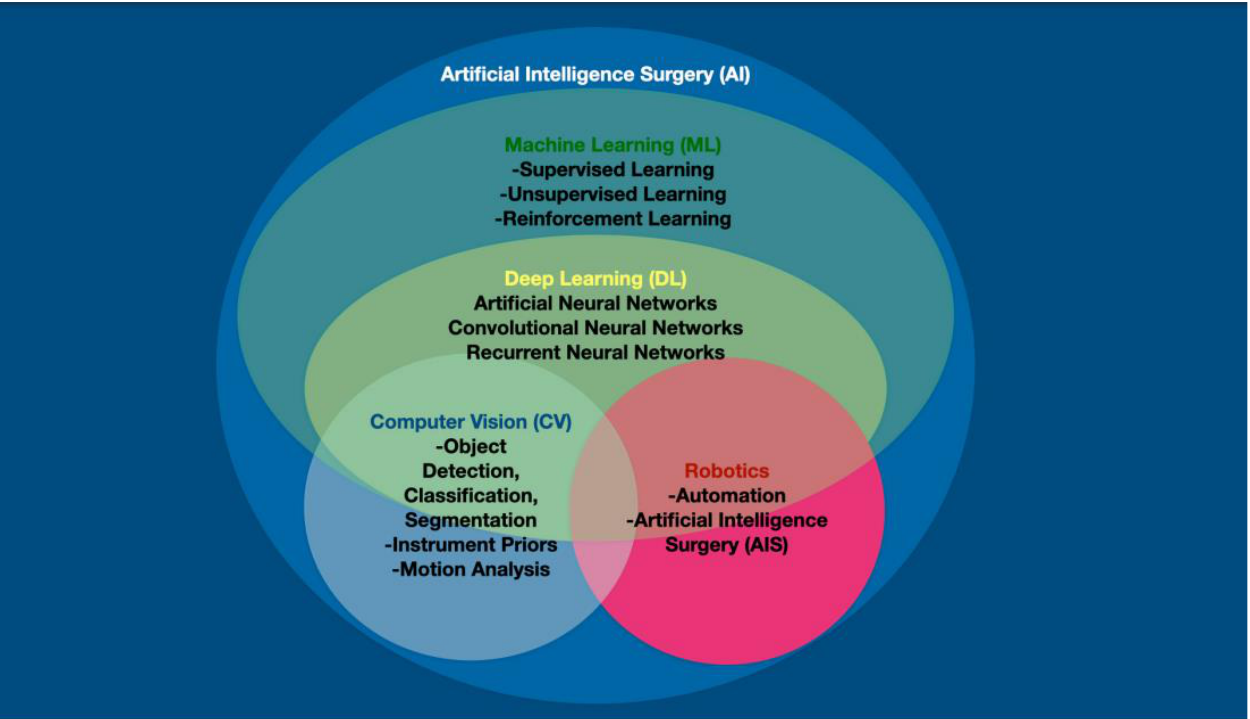
Figure 2. Artificial intelligence (AI) in computerized visualization involves machine learning (ML), which encompasses deep learning (DL). Computer vision (CV) is made possible through the neural networks of DL. Computers and robots may be able to attain autonomous surgical actions through a combination of traditional CV, but also through instrument priors, motion analysis and other non-visual data points.